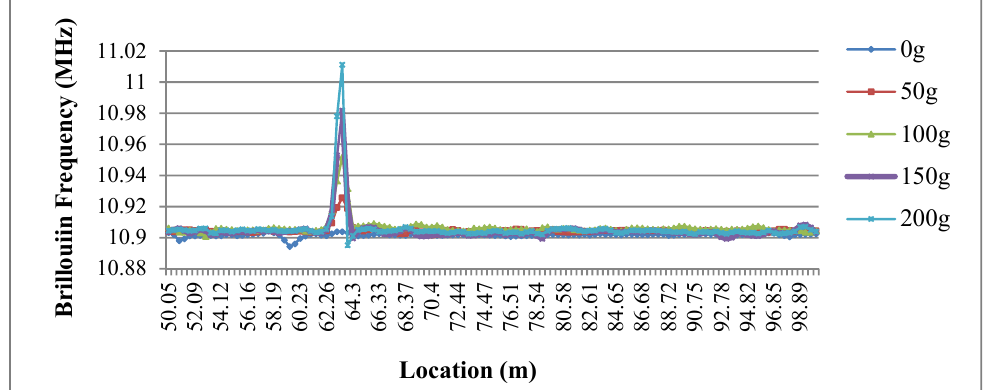
Figure 11. Brillouin frequency results of Load cycle 1 with sensing length of 1